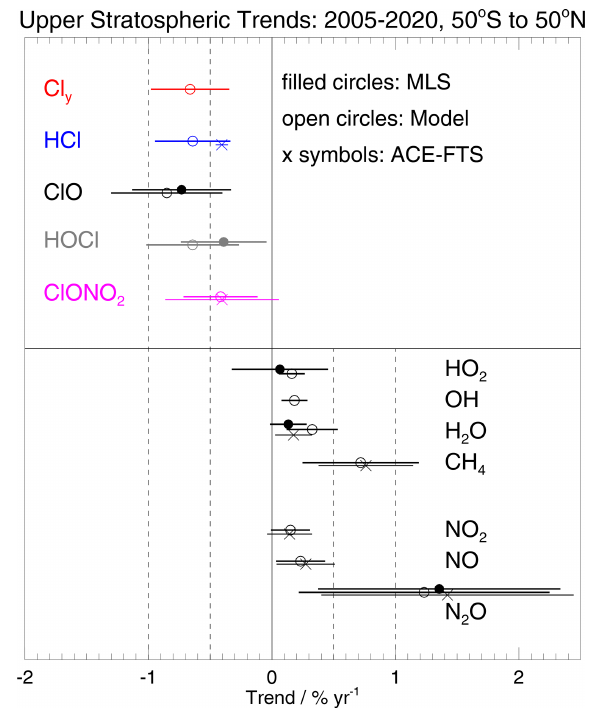
Figure 13. Upper stratospheric trends in various species from 6.8 to 2.2hPa for 50 ◦ S to 50 ◦ N, based on linear trends obtained from the regression fits to daytime time series of MLS data (filled circles) and/or model series (open circles); x symbols are from our analysis of (50 ◦ S to 50 ◦ N) ACE-FTS version 4.1 data over the 33 to 43km range (see text). Error bars represent uncertainties (2 σ ), derived as described in the